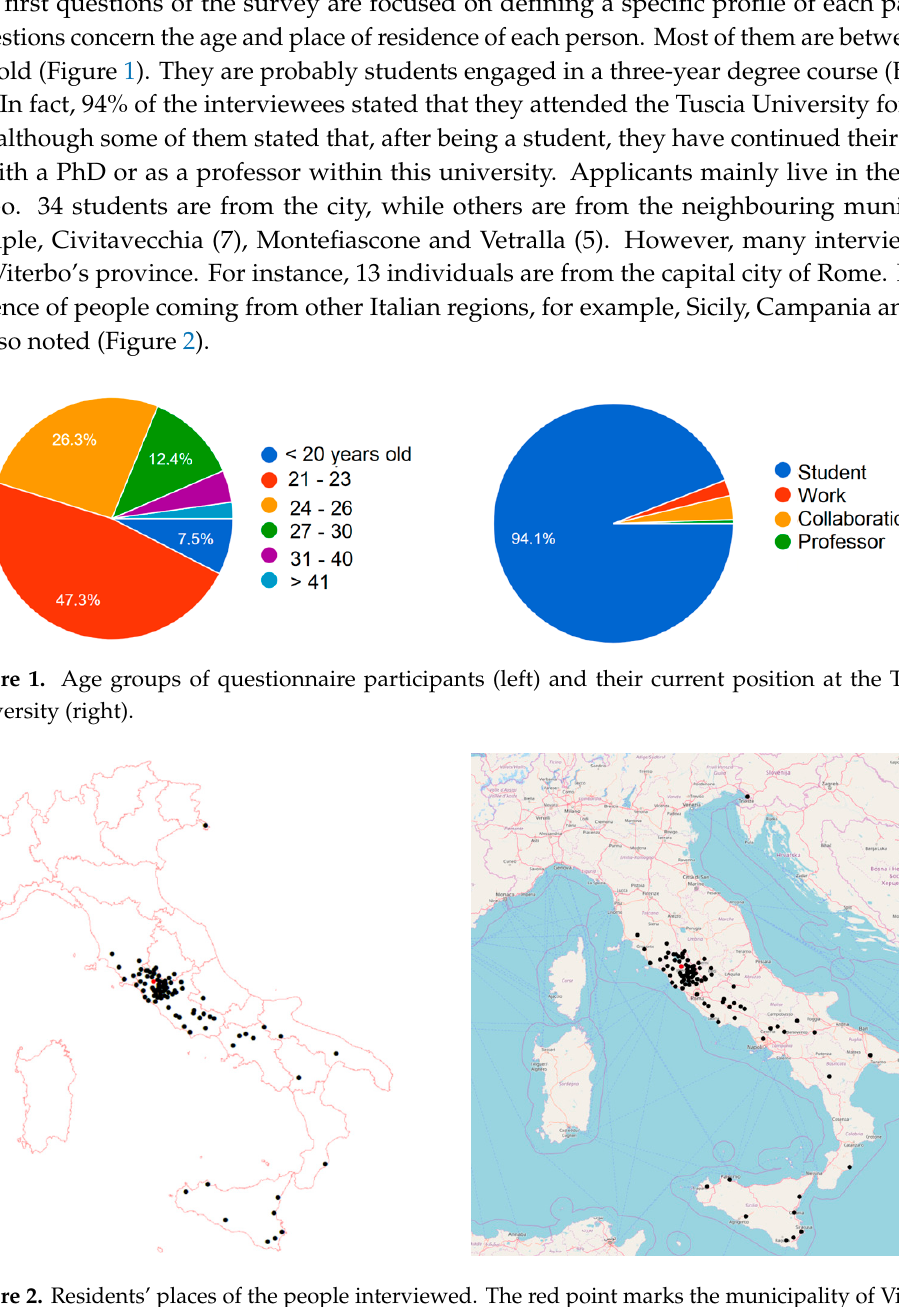
Figure 2. Residents’ places of the people interviewed. The red point marks the municipality of Viterbo. Regional boundaries (left) and infrastructure network (right) are reported in light red.